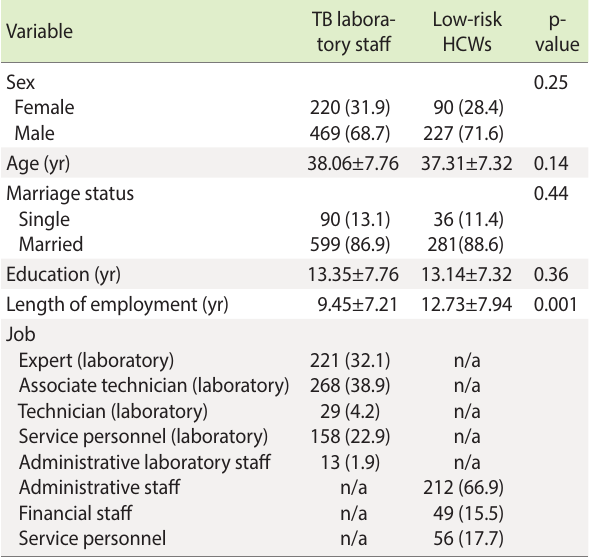
Table 1. Demographic characteristics of TB laboratory staff and